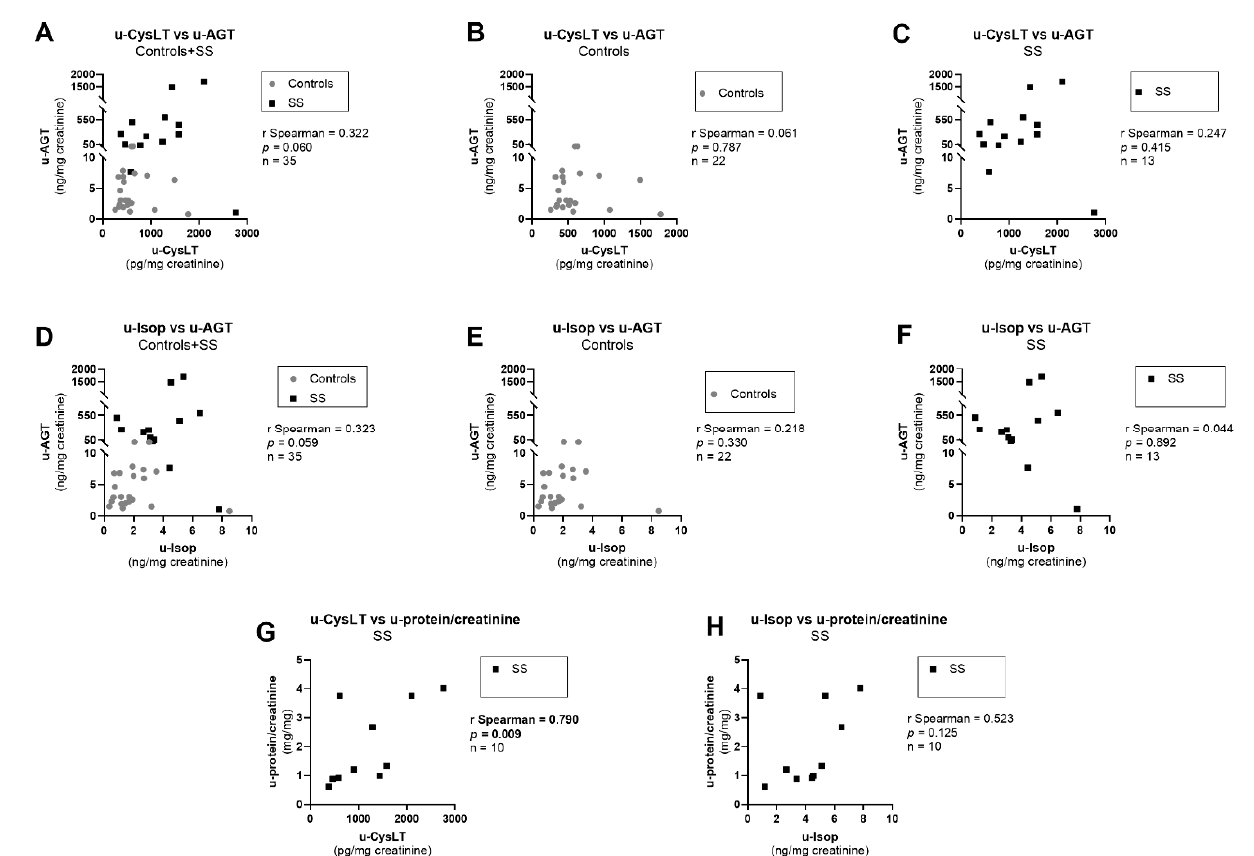
Figure 8. Correlations for u-CysLT or u-Isop with biomarkers of systemic/intra-renal RAAS and renal injury at admission: ( A ) u-CysLT vs. u-AGT in overall study population; ( B ) u-CysLT vs. u-AGT in Controls; ( C ) u-CysLT vs. u-AGT in SS; ( D ) u-Isop vs. u-AGT in overall study population; ( E ) u-Isop vs. u-AGT in Controls; ( F ) u-Isop vs. u-AGT in SS; ( G ) u-CysLT vs. u-protein/creatinine in SS; ( H ) u-Isop vs. u-protein/creatinine in SS. RAAS, renin–angiotensin–aldosterone system; u-AGT, urinary angiotensinogen; u-CysLT, urinary cysteinyl leukotrienes; u-Isop, urinary isoprostanes; u-protein/creatinine ratio, urinary protein/creatinine. The values of u-CysLT, u-Isop and u-AGT were corrected for the respective urinary creatinine concentrations.